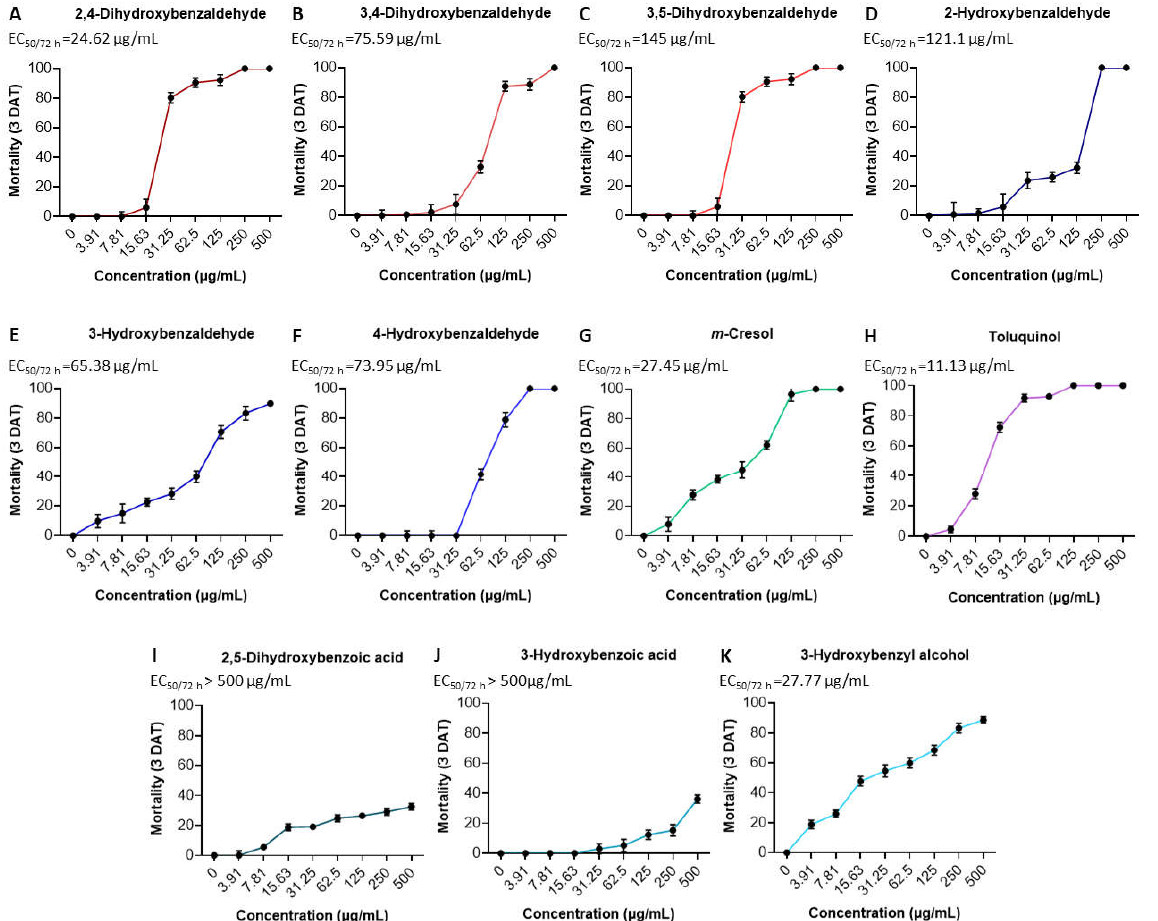
Figure 5. Effect of 2,4-dihydroxybenzaldehyde ( A ), 3,4-dihydroxybenzaldehyde ( B ), 3,5-dihydroxybenzaldehyde ( C ), 2-hydroxybenzaldehyde ( D ), 3-hydroxybenzaldehyde ( E ), 4-hydroxybenzaldehyde ( F ), m-cresol ( G ), toluquinol ( H ), 2,5-dihydroxybenzoic acid ( I ), 3-hydroxybenzoic acid ( J ), and 3-hydroxybenzyl alcohol ( K ) on J2 of Meloidogyne incognita three days after treatment. Each value represents the mean ± standard deviation with three replicates. DAT = days after treatment.